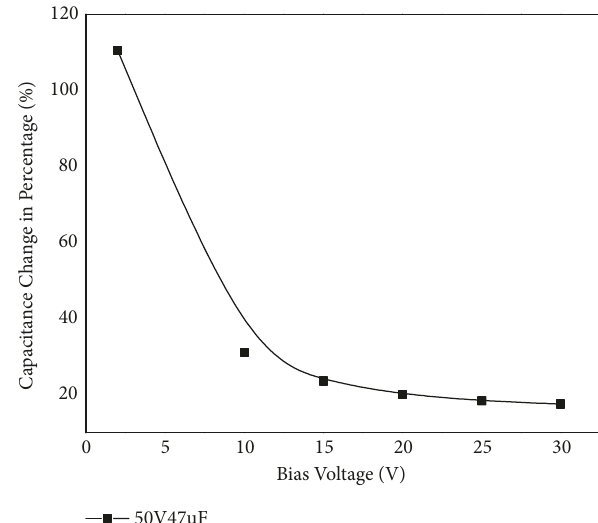
Figure 2: Capacitance-voltage characteristicof 50V47 𝜇 F tantalum capacitors at 125 ∘ C.